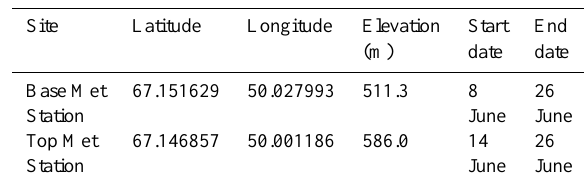
Table C1. Meteorological station sites and associated